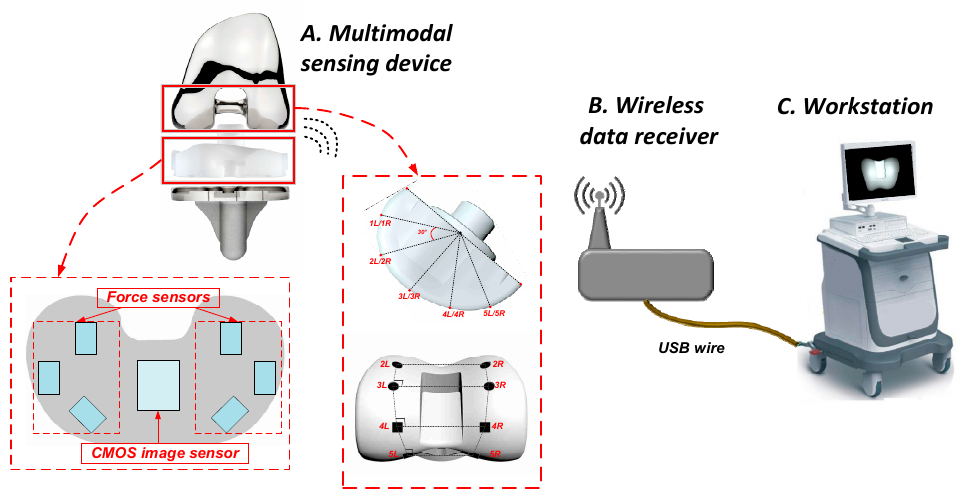
Figure 2. Proposed system architecture.